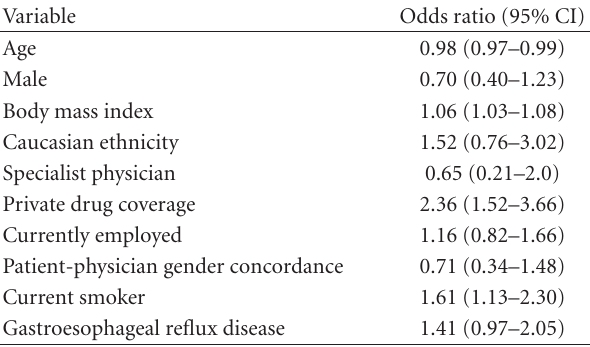
Table 3: Predictors of initiating pharmacotherap y ∗ .